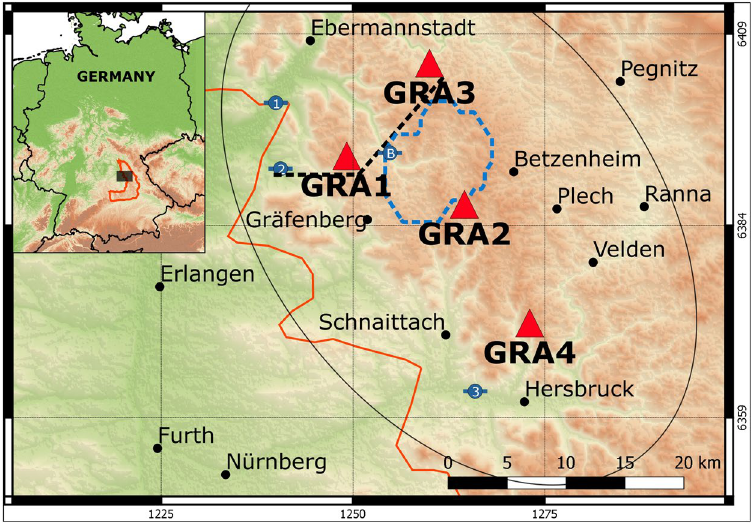
Figure 1. Geographical location of the study area. The GRA stations used in this study are shown as red triangles. The background topography, based on SRTM (Shuttle Radar Topography Mission 63 ), is colored and shaded. The altitude ranges from 200 m to 800 m (green to brown). The piezo metric stations (1 to 3) and the Bärenthal discharge station (B) are shown as blue symbols, while the dashed blue line outlines the modeled watershed. The contour of the Franconian Jura 32 is outlined in orange. The black dashed line shows the location of the cross-section of Fig. 2. The thin black contour shows the approximate area of maximum sensitivity of the dv/v measurements. The cities, coastlines and country borders are obtained from “Natural Earth data”. This map has been plotted in QGIS 61 .